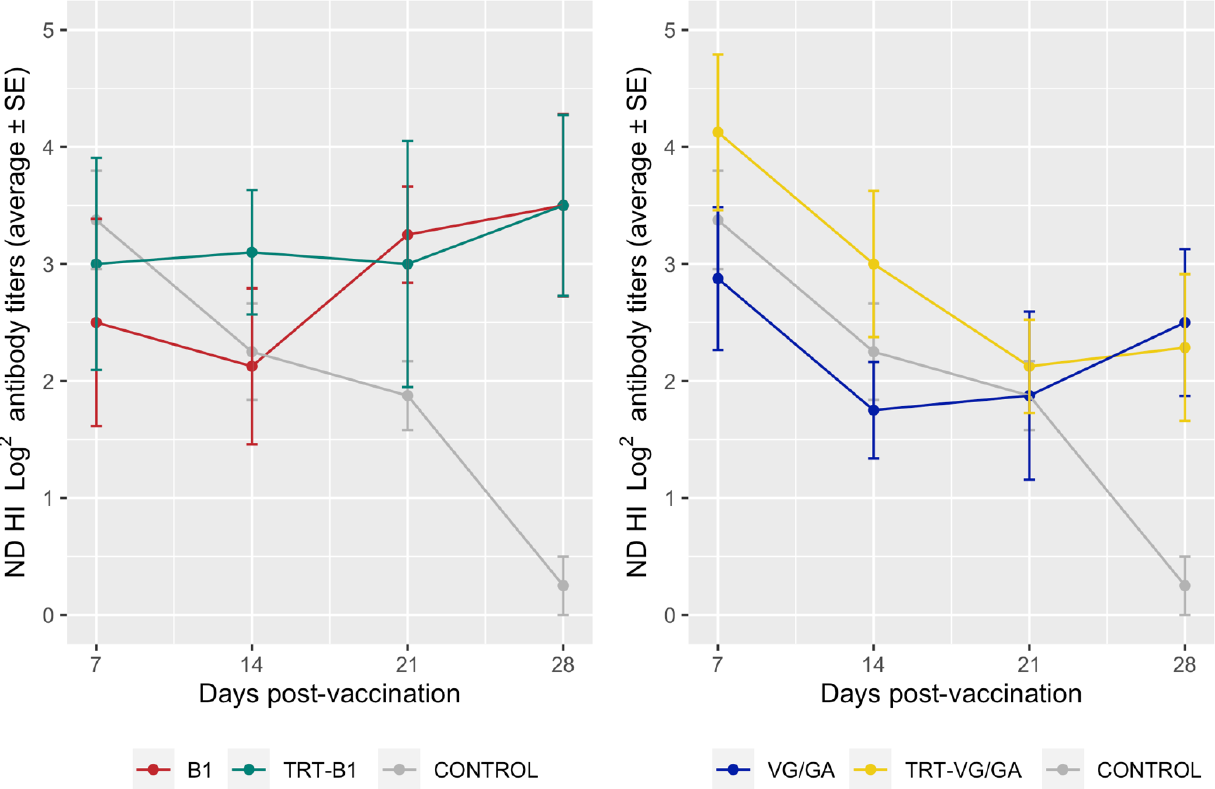
Figure 3. NDV-HI titers measured in groups vaccinated with vaccine strains B1 ( left ) and VG/GA ( right ) compared to the control group.